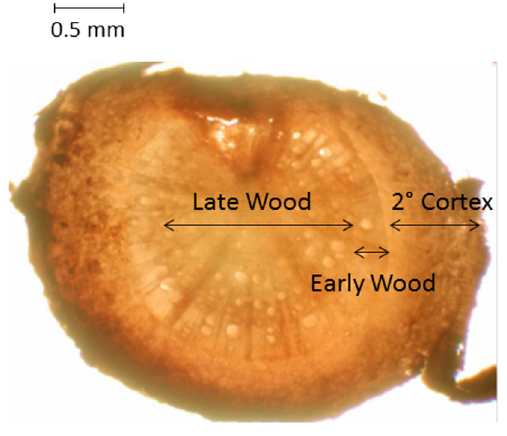
Figure 2. Sassafras albidum root cross-section. Micrograph depicting how higher-order roots (approximately 4 th or 5 th order) were dissected prior to d 13 C analysis in 2008.